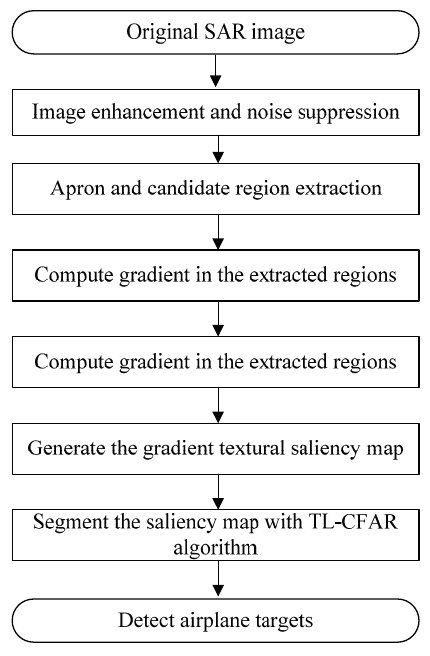
Figure 5. Aircraft detection algorithm proposed in this